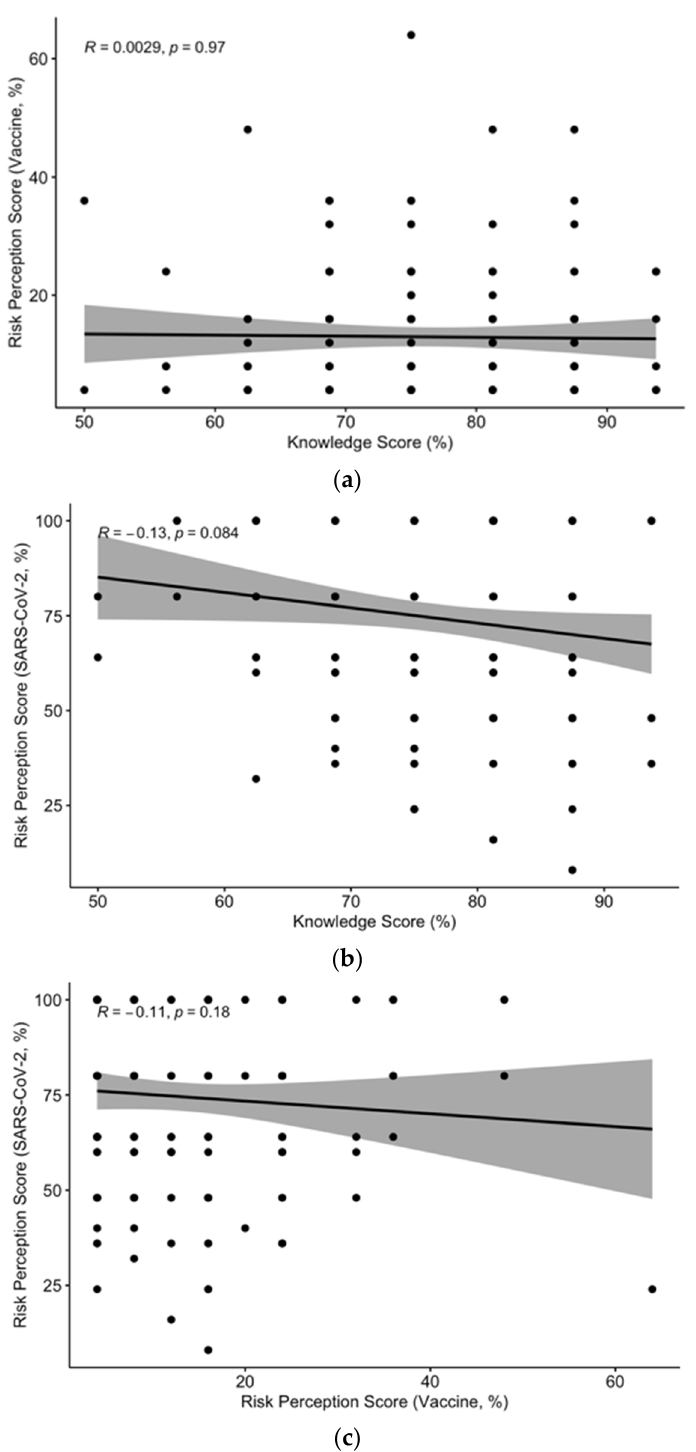
Figure 2. Scatter plots representing (left to right): ( a ) correlation between general knowledge score (%) and risk perception score (%) for SARS-CoV-2 vaccines (R = 0.0029, p = 0.97). ( b ) General knowledge score (%) and risk perception score for SARS-CoV-2 infection (R = − 0.13, p = 0.084). ( c ) Risk perception score (%) for SARS-CoV-2 vaccines and for SARS-CoV-2 infection (R = − 0.11, p = 0.18).